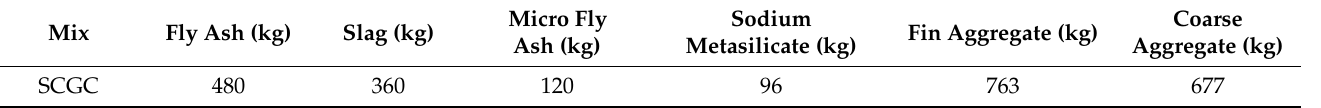
Table 4. Mix design of SCGC (kg per 1 m 3